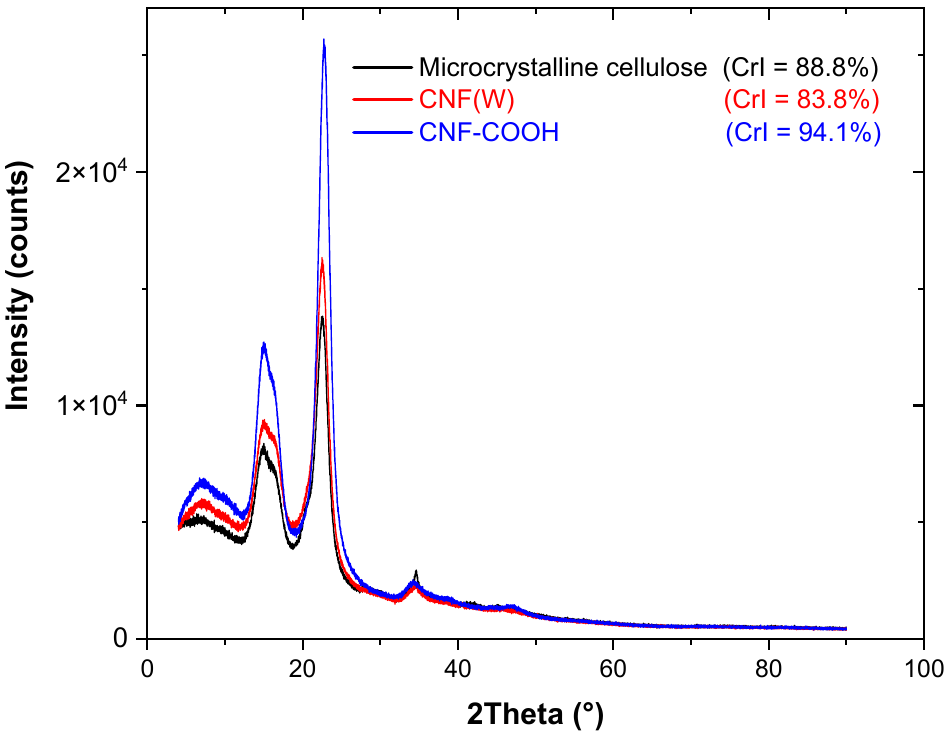
Figure 6. XRD of nanocellulose fibres (CNF(W)) -red line; and nanocellulose fibres functionalized with carboxyl groups (CNF-COOH) - blue line and microcrystalline cellulose - black line, with the corresponding crystallinity indices (CrI).